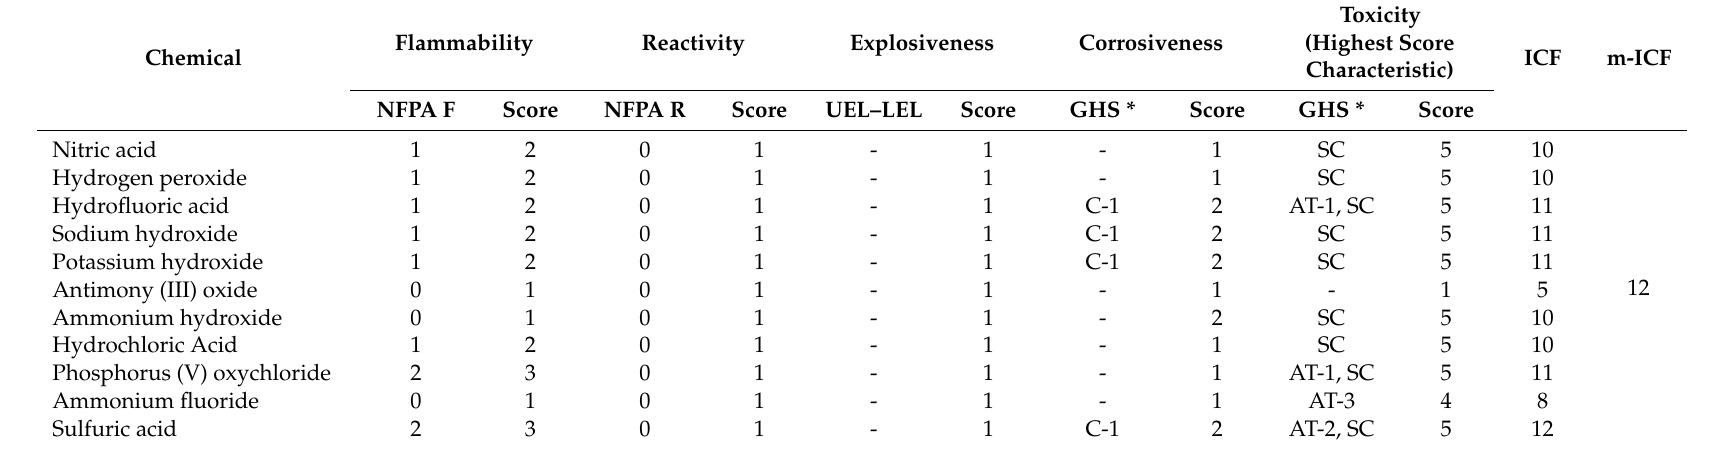
Table 2. The scoring to the individual chemical factor (ICF) of each chemical and maximum ICF value (mICF) of example enterprise.